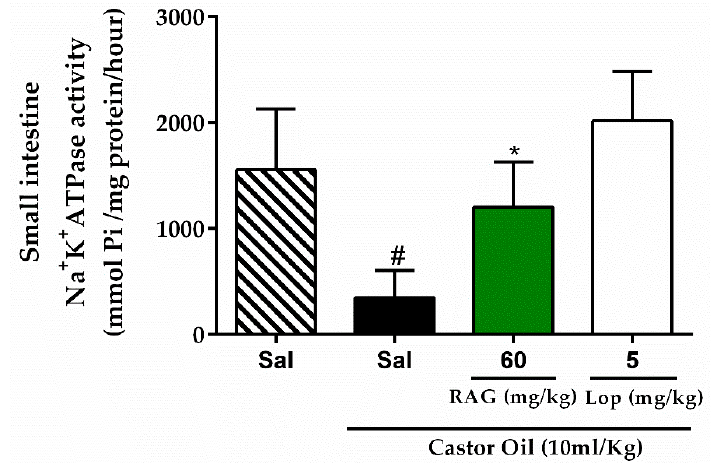
Figure 3. E ff ect of RAG on Na + / K + -ATPase activity in castor oil-induced diarrhea in mice. All animals received castor oil (10 mL / kg) by gavage to induce diarrhea. The results are expressed as mean ± SEM. A minimum of six animals were used per group. # p < 0.05 vs. saline control group; * p < 0.01 vs. saline + castor oil group. Statistics: one-way ANOVA with Tukey post-hoc test. Abbreviations: RAG: red